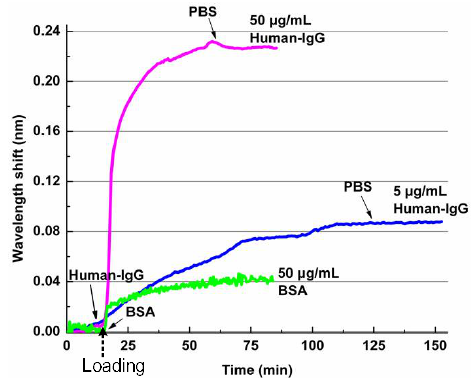
Figure 29. The responsivities of the PA surface functionalized photonic biosensor to specific and